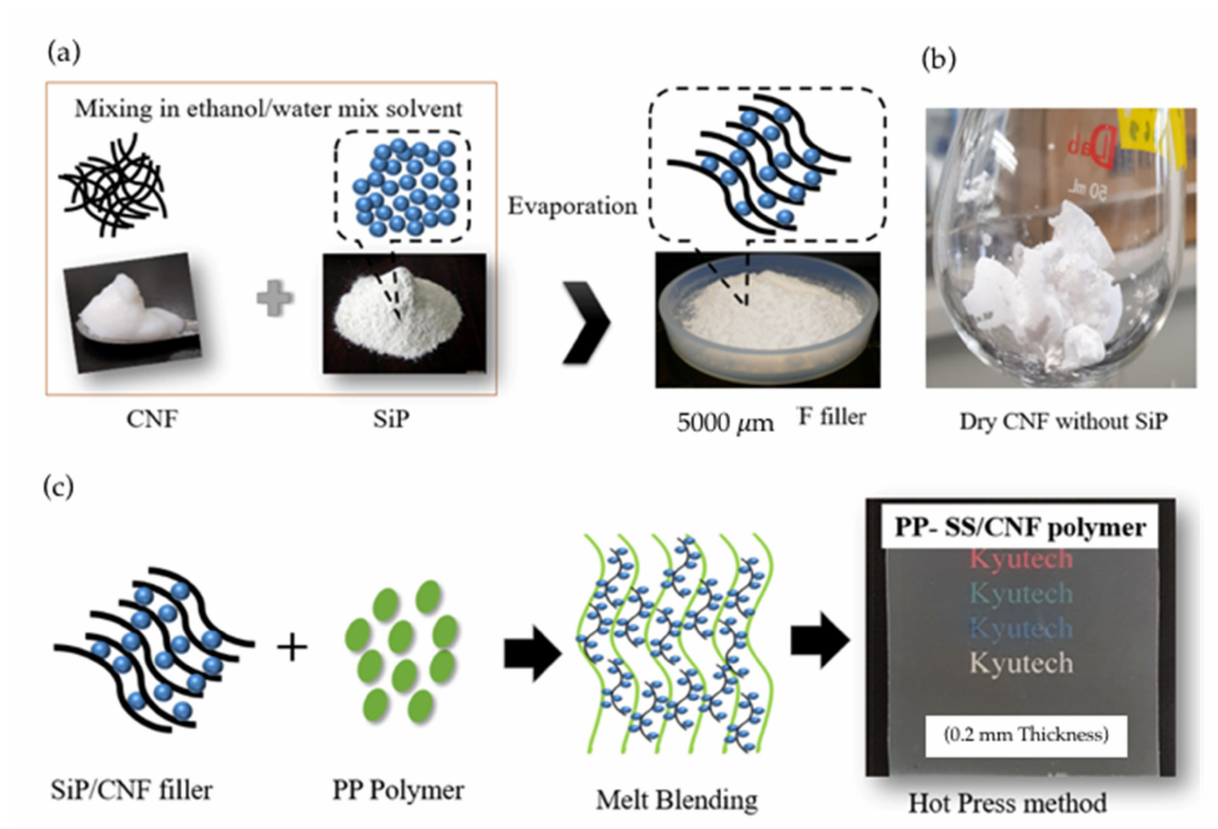
Figure 2. Images of SiP/CNF filler; ( a ) hybrid filler preparation, ( b ) agglomerated CNFs without SiPs and ( c ) hybrid filler mechanism in PP